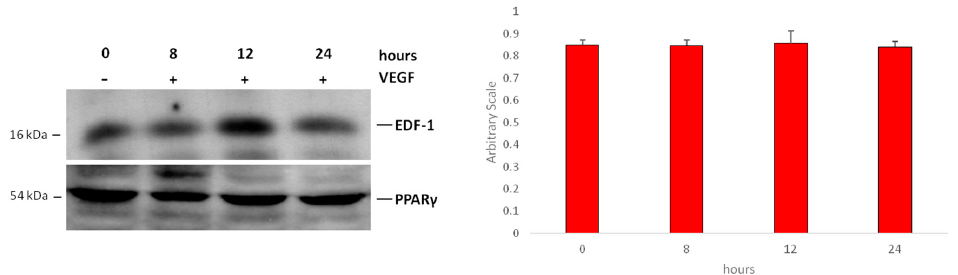
Figure 3. The interaction between EDF1 and PPAR γ in HUVEC treated with VEGF. HUVEC were treated with VEGF (50 ng/mL) for different times. Cell lysates were immunoprecipitated with monoclonal antibodies against PPAR γ and analyzed by western blot using rabbit antibodies against EDF1 ( upper panel ). The filter was then probed with rabbit anti-PPAR γ antibodies to verify the equal amounts of immunoprecipitated proteins ( lower panel ). Densitometric analysis was performed using ImageJ software. EDF1/PPAR γ ratio was calculated on three blots from separate experiments ± standard deviation.